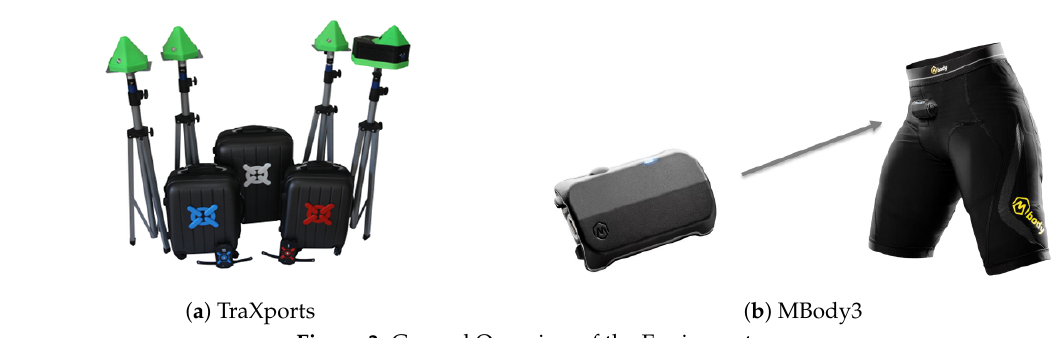
Figure 3. General Overview of the Equipment.